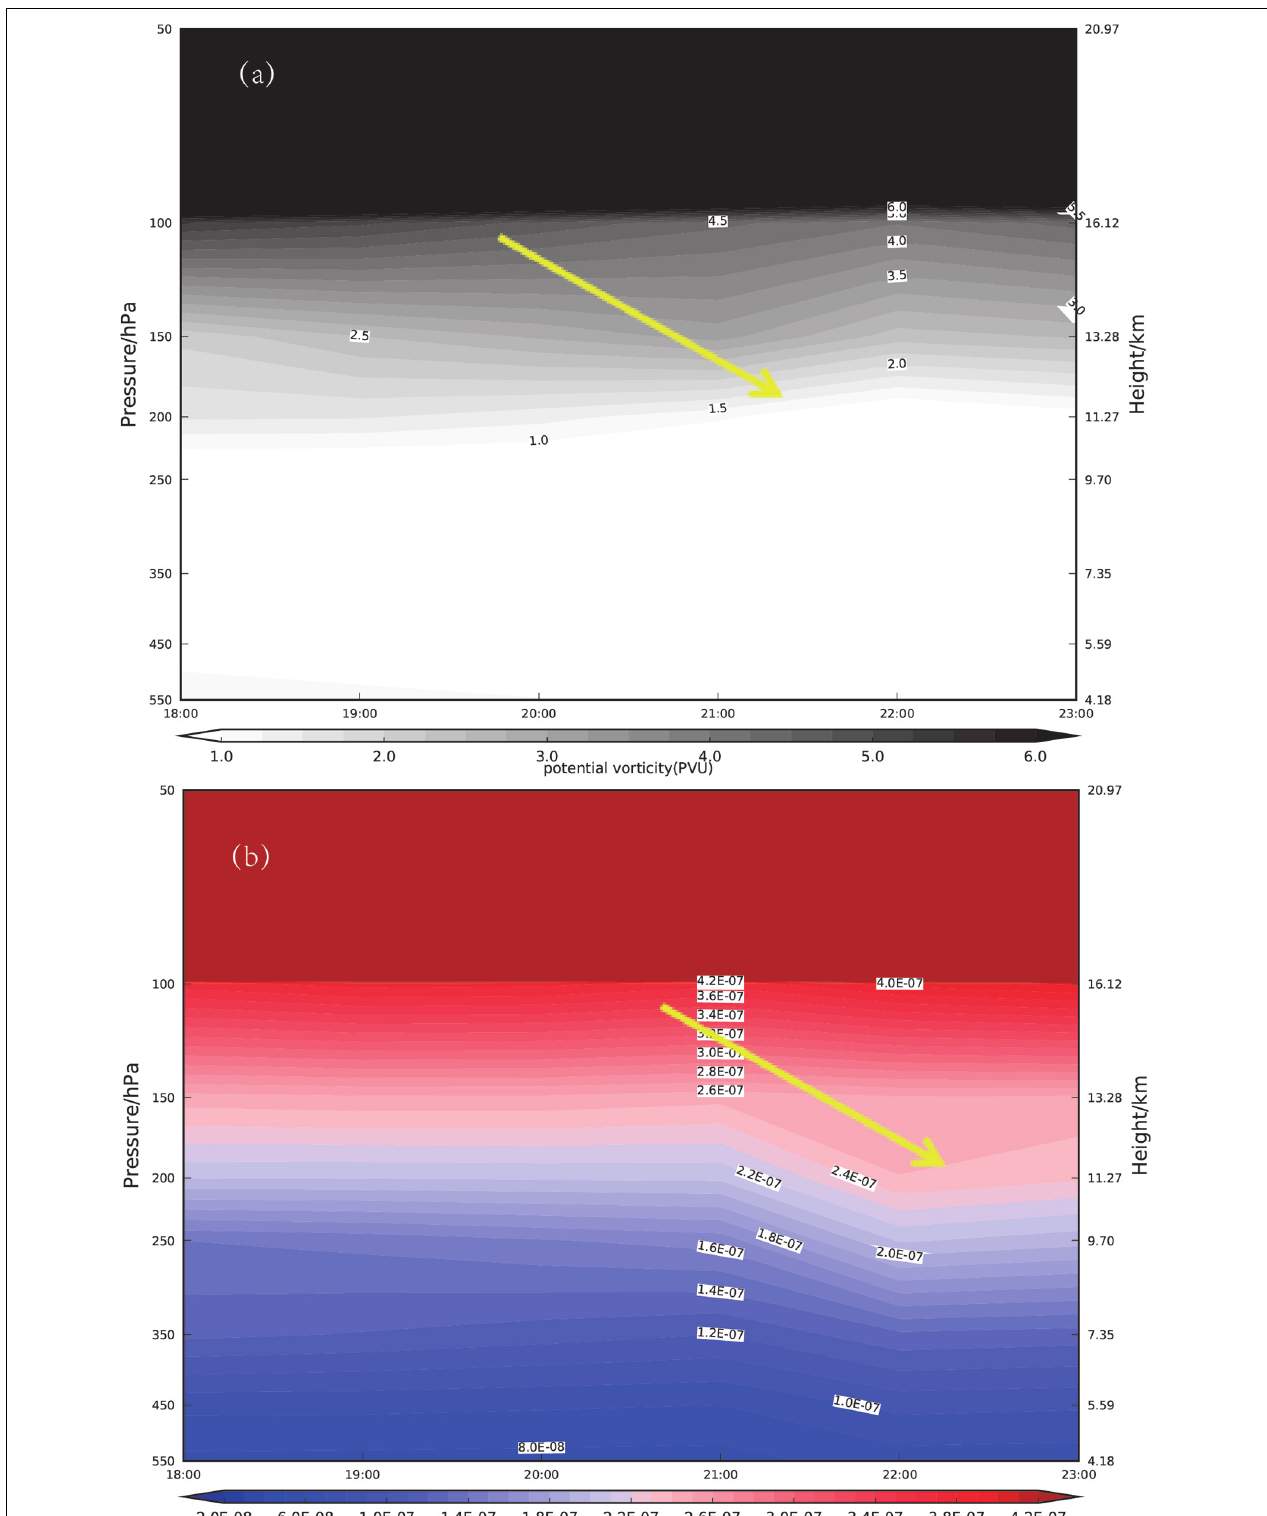
FIGURE 7 | The time evolution of the vertical distribution of (a) potential vorticity (PV) and (b) ozone mixing ratios from ERA5 reanalysis data for the period 18:00–23:00 on 3 May, 2014 above 28 ◦ N, averaged between 92.5 ◦ E and 98.5 ◦ E.